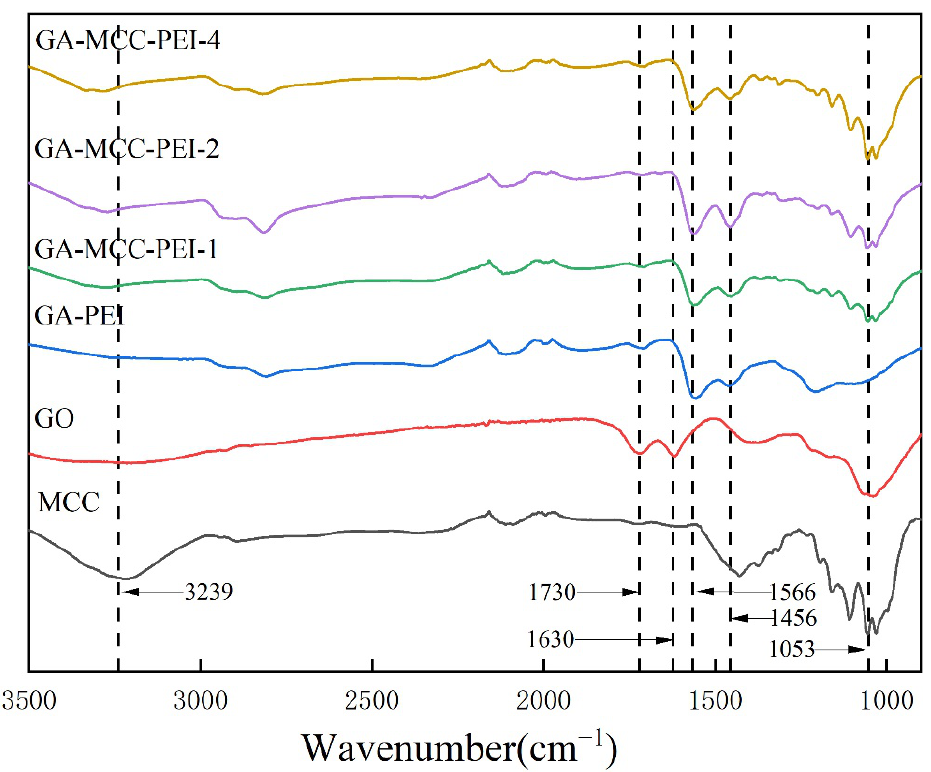
Figure 3. Infrared spectra of GO aerogel, MCC aerogel, GA-PEI aerogel, and GA-MCC-PEI-(1, 3, 5) aerogels.